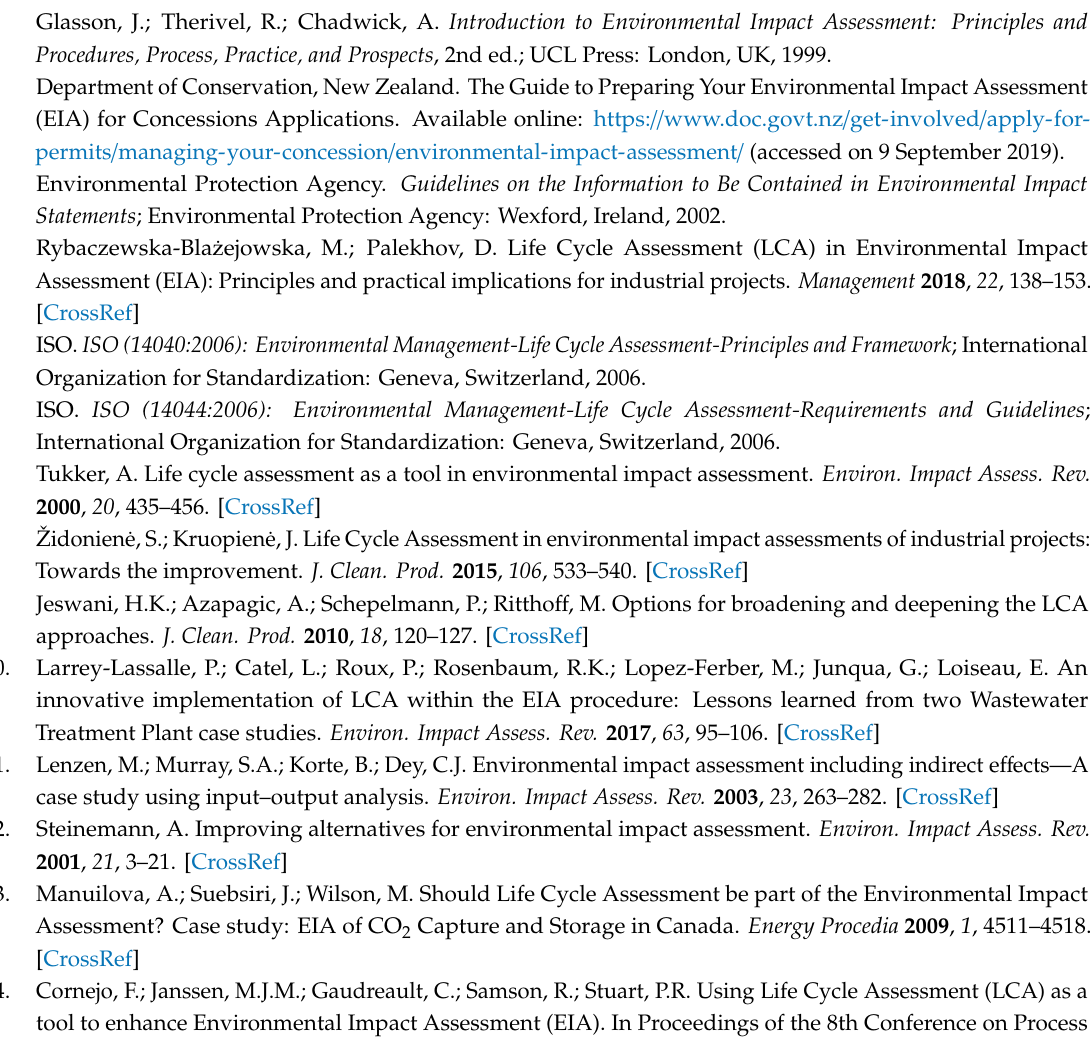
Figure S1: Basic steps followed in LCA, Table S1: Di ff erent categories of project based on their size, Table S2: Procedure to conduct an EIA, Table S3: Impact Categories assessed by EIA for DP1, Tables S.A–S.I: Details on material intensities used in LCA for Pedestrian pathway, undercroft, PRT parking, Asphalt road, electric car parking, maintenance for electric car parking and asphalt road, PRT pod, buildings and operation energy respectively, Table S4: Product Systems used for sensitivity analysis, Table S5: Results for sensitivity analysis, Table S6: Product system and processes used for LCA